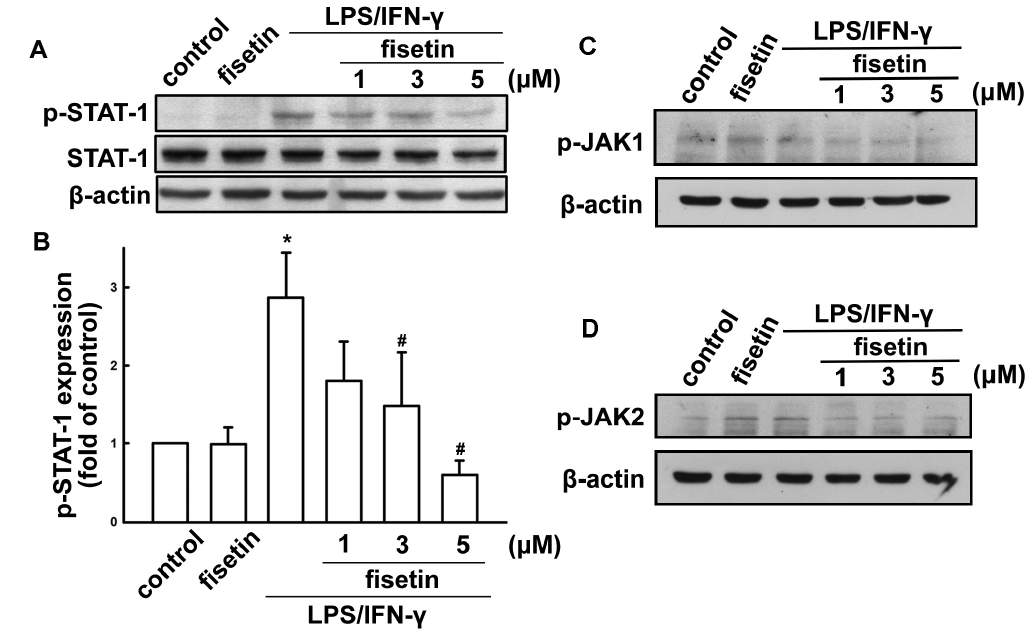
Figure 4. Fisetin suppresses LPS/IFN- γ -induced STAT signaling pathways. BV-2 microglial cells were pretreated with fisetin (1, 3, or 5 μ M) for 60 min, then exposed to LPS (10 ng/mL) plus IFN- γ (10 ng/mL) for another 60 min. The phosphorylated levels of STAT-1, JAK1 or JAK2 were determined by western blot analysis, and the signal intensities were normalized to total protein expression. The results are expressed as mean ± S.E.M. from 3 independent experiments. * p < 0.05 compared with the vehicle control treatment group. # p < 0.05 compared with the LPS/IFN- γ treatment alone